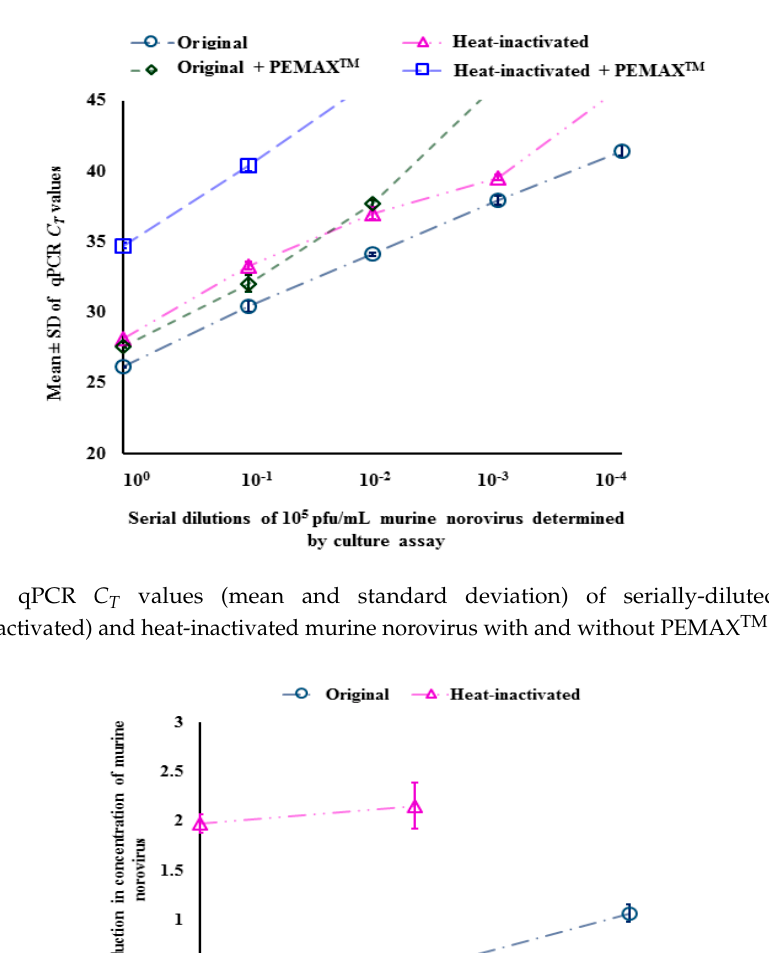
Figure 1. Differences in qPCR C T values (mean and standard deviation) for original (non-heat- inactivated) and heat-inactivated murine norovirus with and without PEMAX TM treatment .